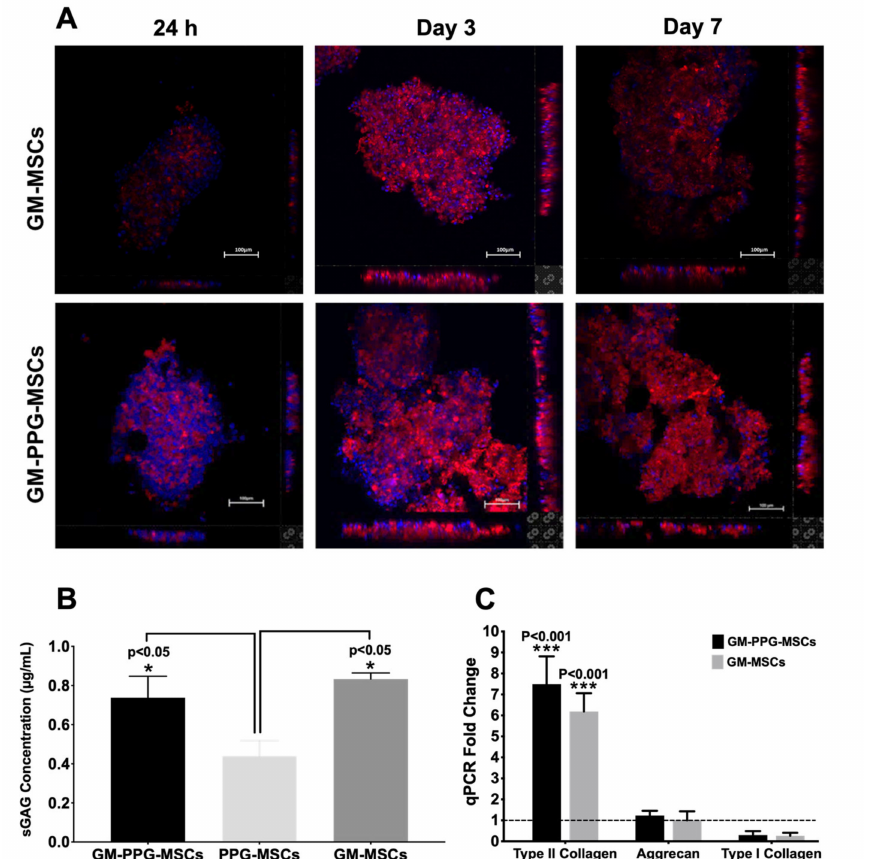
Figure 5. The effect of PPG on MSCs’ chondrogenic differentiation in a 3D culture. ( A ) Immunoflu- orescence staining of type II collagen indicates increased expression from day 1 to day 7. The bar graph shows ( B ) the sGAG production and ( C ) chondrogenic gene expression of MSCs in 3D culture. Only type II collagen gene expression is significantly increased in GM-PPG-MSCs and GM-MSCs group relative to the PPG-MSCs group (control). Scale bar measures 100 µ m (* p < 0.05, *** p <